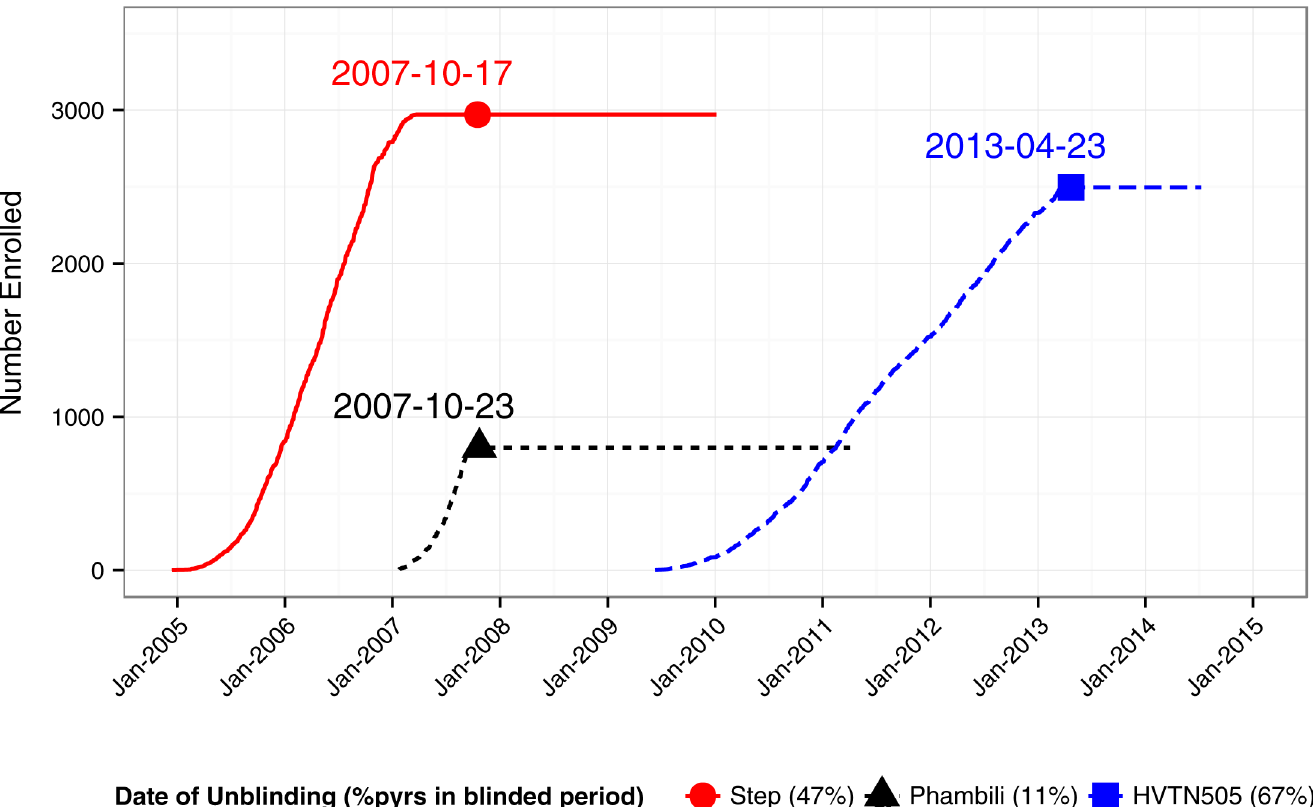
Fig 1. Enrollment and Follow-up in Step, Phambili and HVTN505. Indicated are dates of unblinding when data were frozen for pre-unblinding analyses, and the percent of person-years (% pyrs) occurring during the blinded period. HVTN505 is still in active follow-up; HVTN505 data included in the meta- analysis are as of July 9,